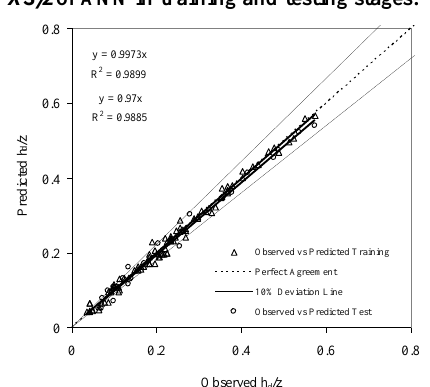
Figure 21. Comparison between observed and predicted XS/z of ANN in training and testing stages.